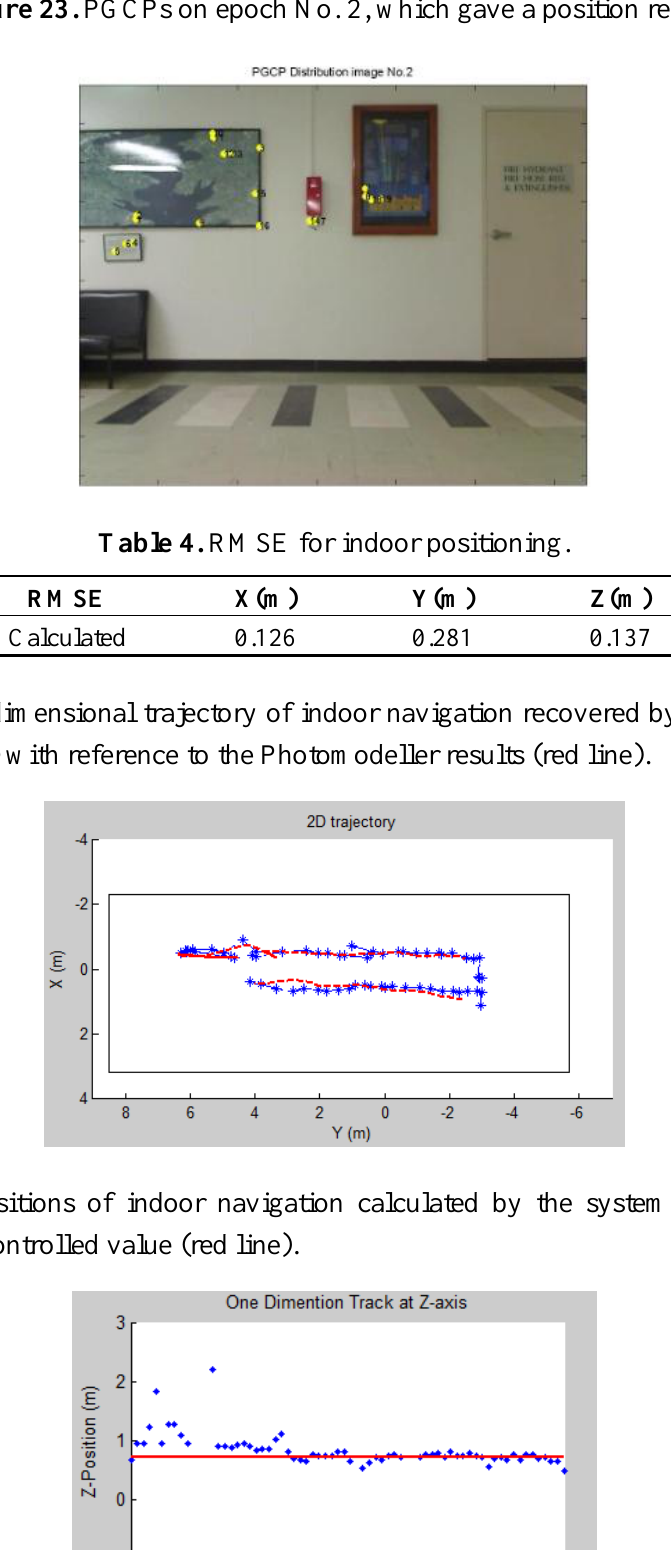
Figure 23. PGCPs on epoch No. 2, which gave a position result.